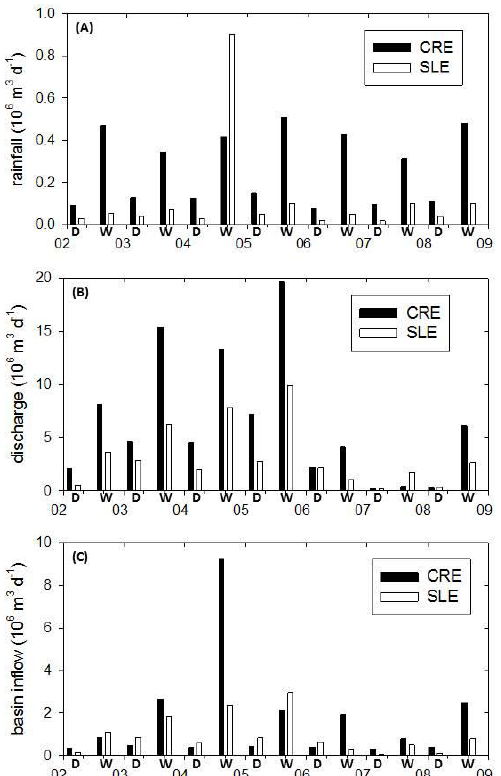
Fig. 3. Comparative seasonal time series of water budget compo- nents for CRE and SLE. CRE (filled) and SLE (open) bars are paired seasonally with the first pair of each year representing the dry sea- son. All values are in 10 6 m 3 d − 1 . (A) Rainfall; (B) discharge; (C) basin inflow = tributaries + ground water.